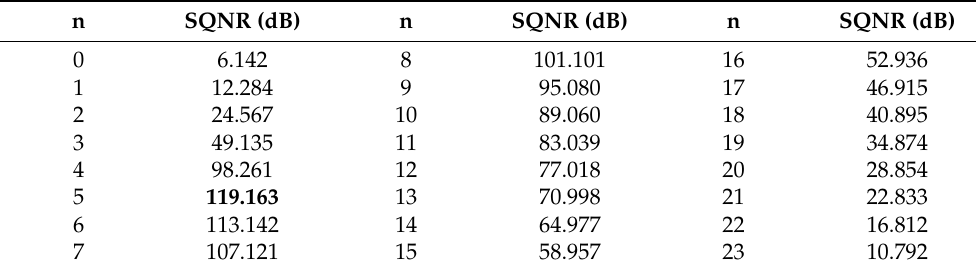
Table 1. SQNR (dB) of the 24-bit fixed-point quantizer for different values of the parameter n . n SQNR